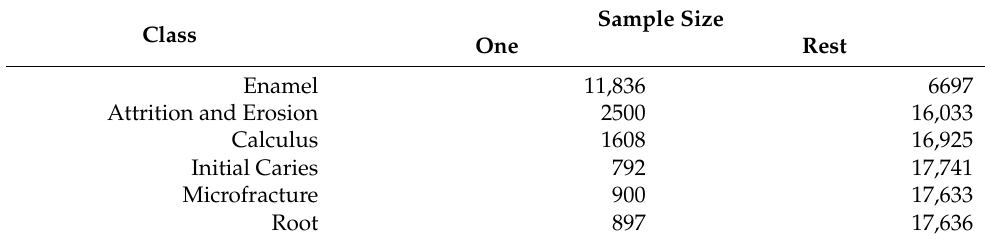
Table 5. The sample size for each class in the one-vs-rest classification.